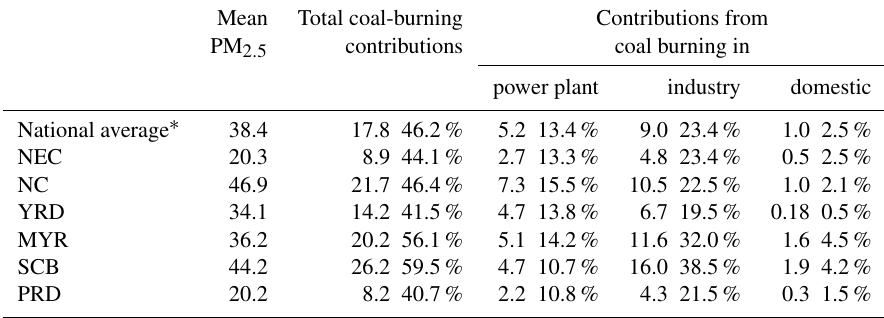
Table 5. Seasonal absolute contributions (µgm − 3 ) and percentage contributions from coal burning in